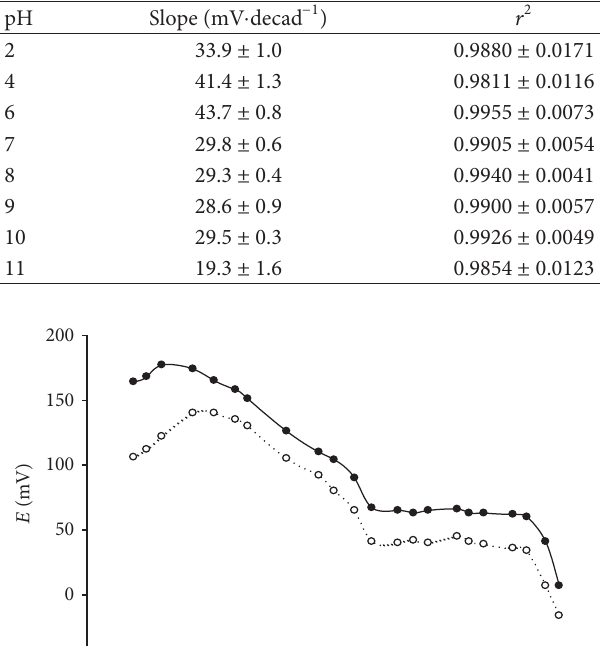
(Figure 7). e electrode yielded steady potentials within 5–10 s. e potentials remained constant for about 150 s.